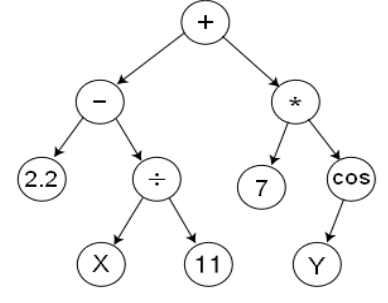
Fig.4. A function represented as a tree